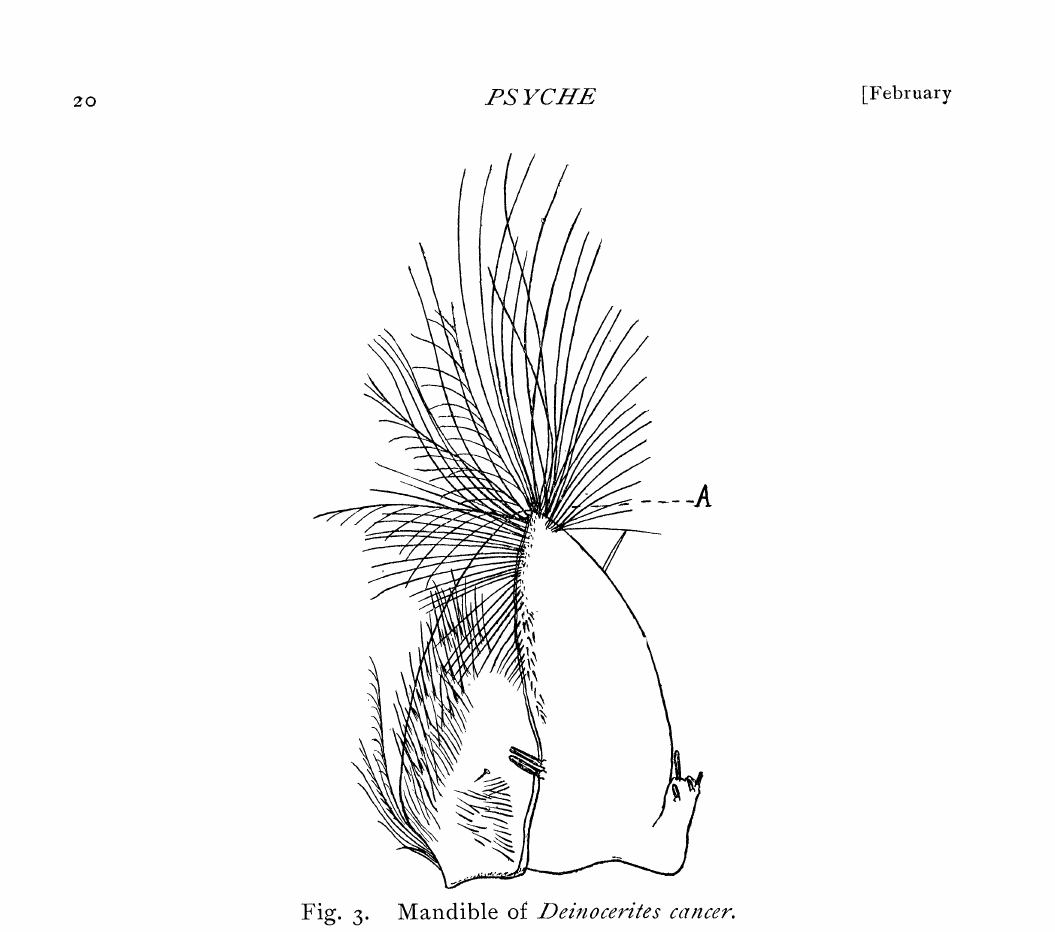
Fig. 3" Mandible of Deinoceriles